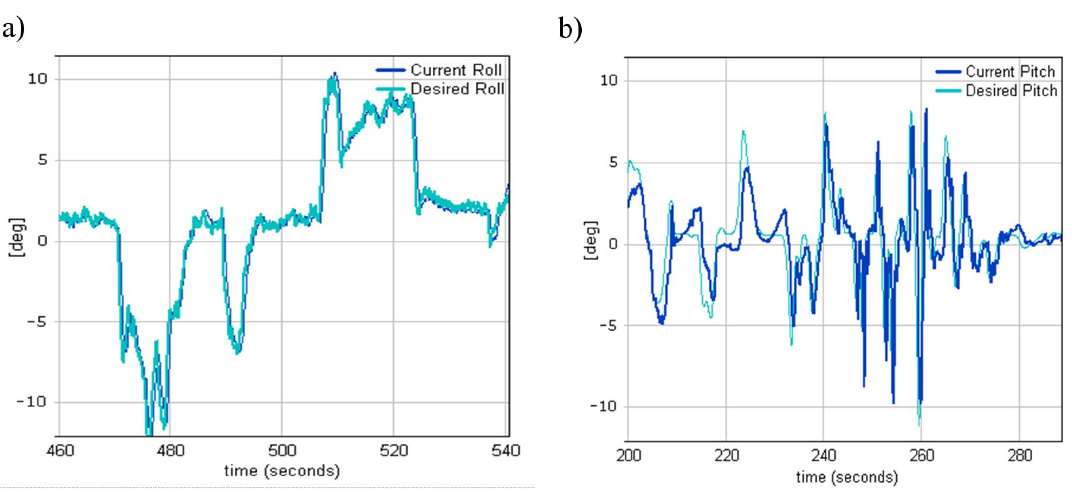
Figure 9. a ) Current and desired roll angle. b ) Current and desired pitch angle. Figure 9. ( a ) Current and desired roll angle. ( b ) Current and desired pitch